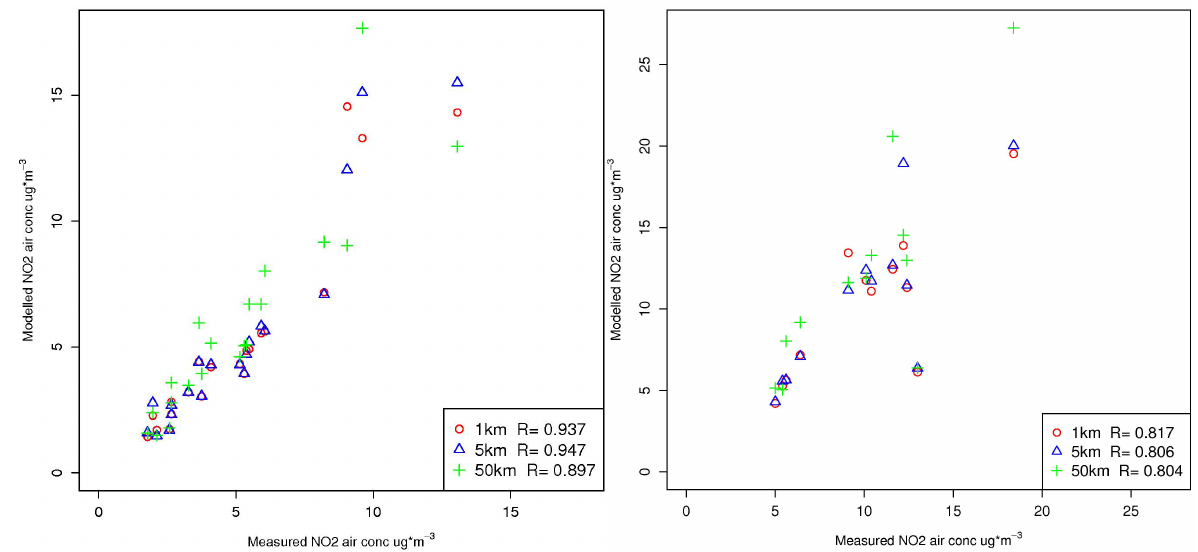
Fig. 5. Correlation with measurements of NO 2 (µgm − 3 ) from the rural monitoring network (left) and rural sites in the Automatic Urban and Rural monitoring Network (right) for 1km, 5km and 50km model resolution data.